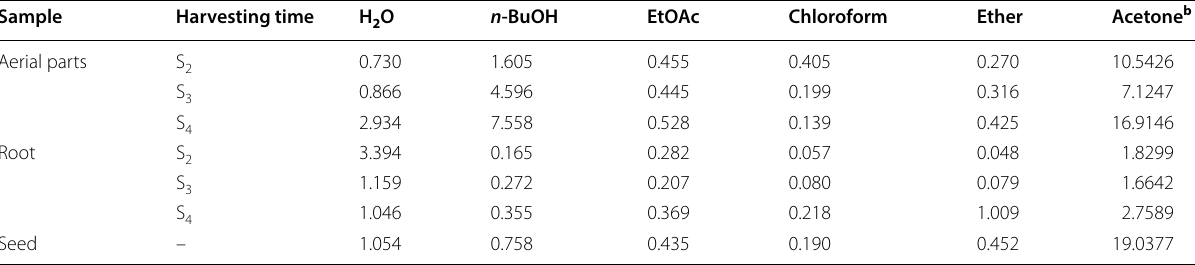
Table 3 The amounts of phenolic compounds in the tissues extracts of the C. heratensis (mg GAE/g DM a )